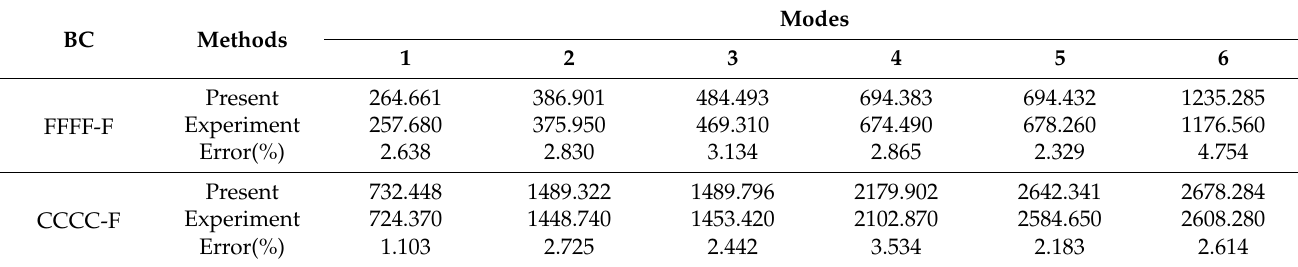
Table 7. The first six natural frequencies of the square plate with a central cutout.